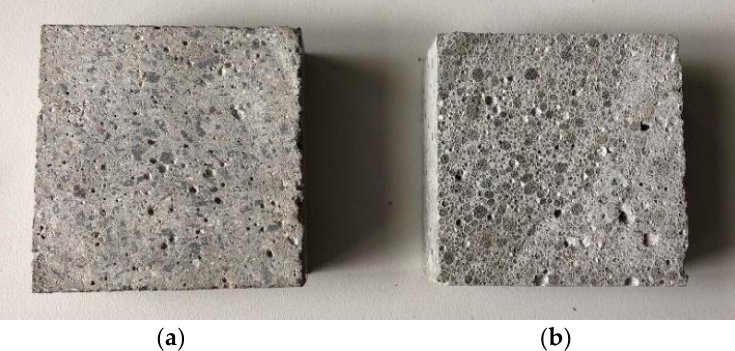
Figure 8. Cross-section of ( a ) the control sample (CS) and ( b ) E100 mixtures samples with uniform distribution of EGA in the cement matrix.